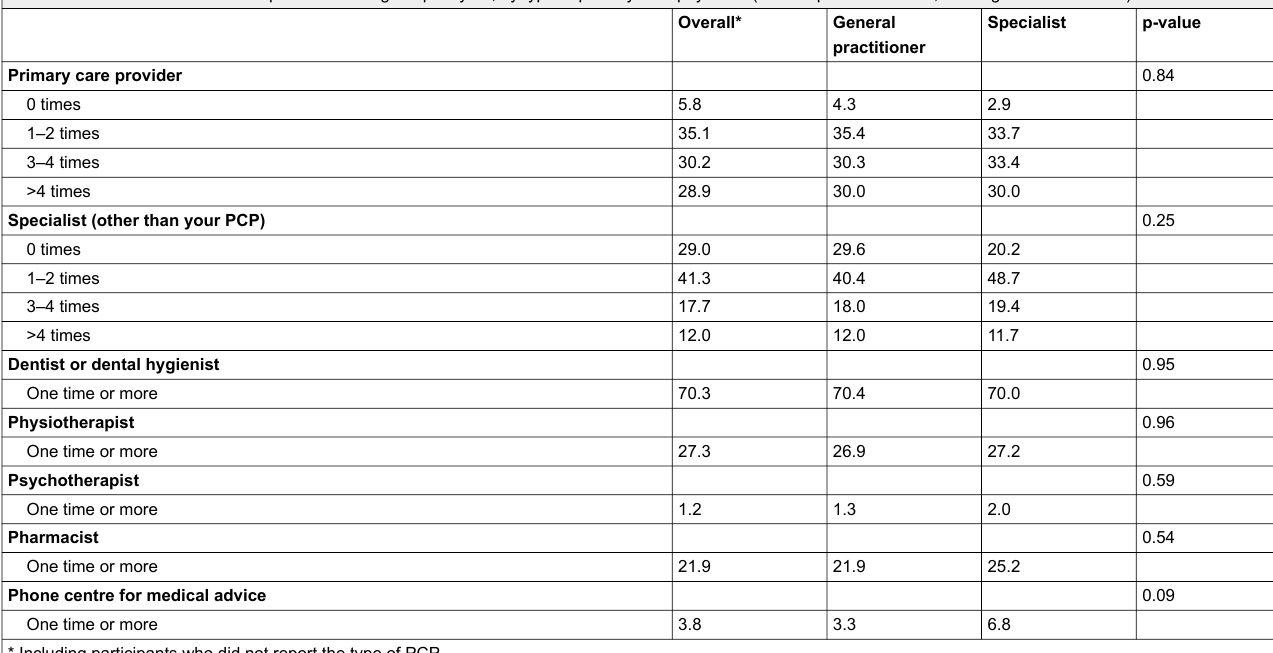
Table 3: Outcomes – visits to care providers during the past year, by type of primary care physician (all data presented as %, missing values excluded).